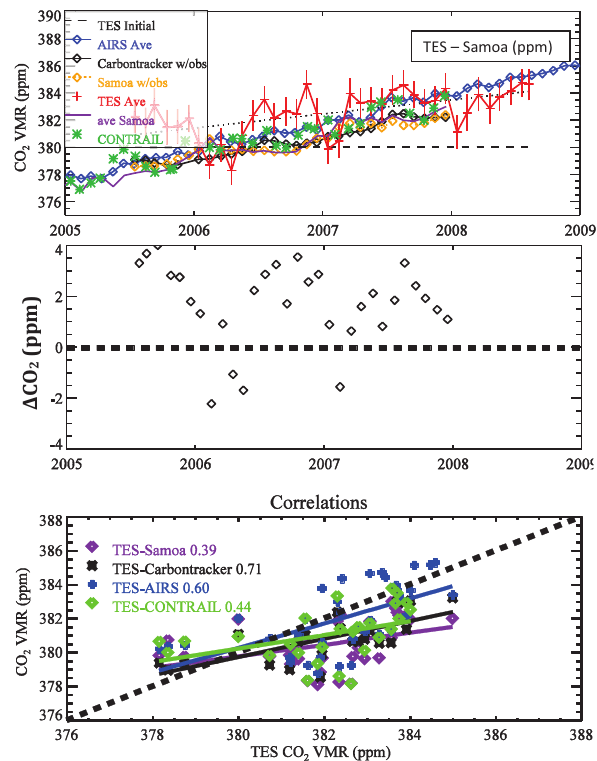
Fig. 10. Comparison of TES (at ∼ 5km, red), Samoa surface data (purple), CarbonTracker (5km), AIRS ( ∼ 9km, blue), and CON- TRAIL aircraft data (10–11km, green) in the Southern Hemisphere (10 ◦ –30 ◦ S, 128 ◦ –168 ◦ E). The top panel shows a time series of the different datasets, where the TES initial and a priori values are set to 380ppm (dashed line). The middle panel shows TES – Samoa with TES observation operator. The bottom panel shows TES (x-axis) plotted versus the above